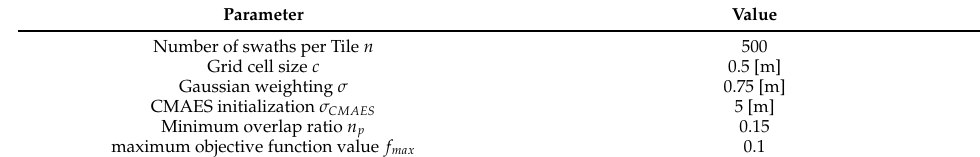
Table 5. Parameter settings for AUV dataset experiment.